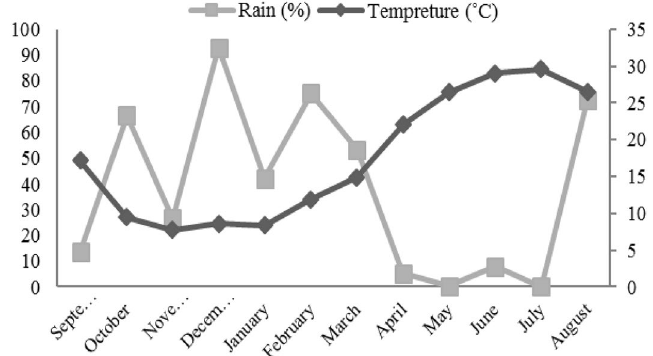
Figure 1. Meteorological data from September 2017 to August 2018 for the experimental site of the study (National Meteorological organization, Iran).